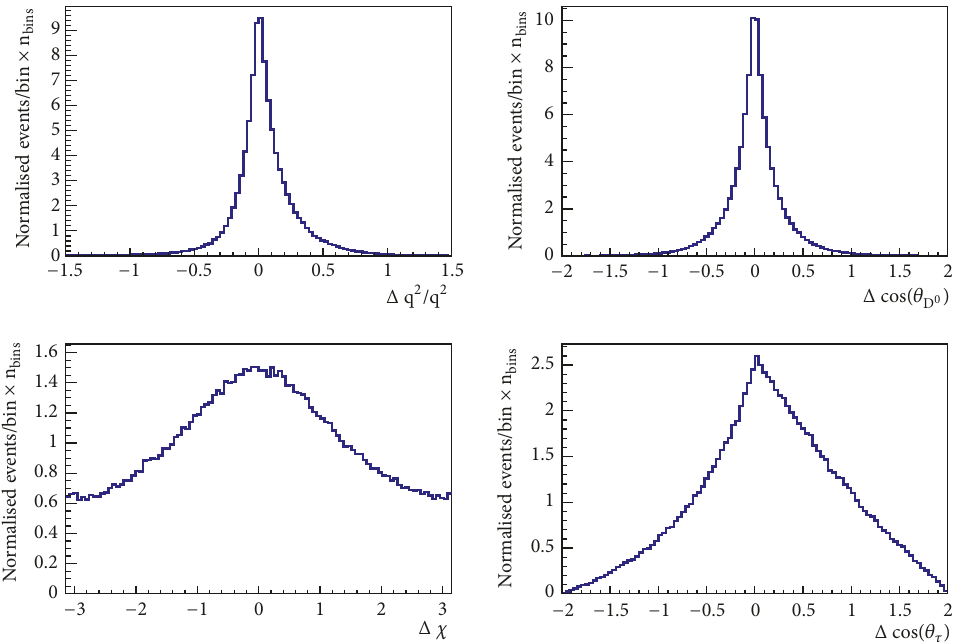
Figure 9: Resolution on the phase space variables for 𝐵 󳨀→ 𝐷 ∗+ 𝜏 − (󳨀→ 𝜇 − ] 𝜇 ] 𝜏 ) ] 𝜏 decays, obtained with equal velocity algorithm.